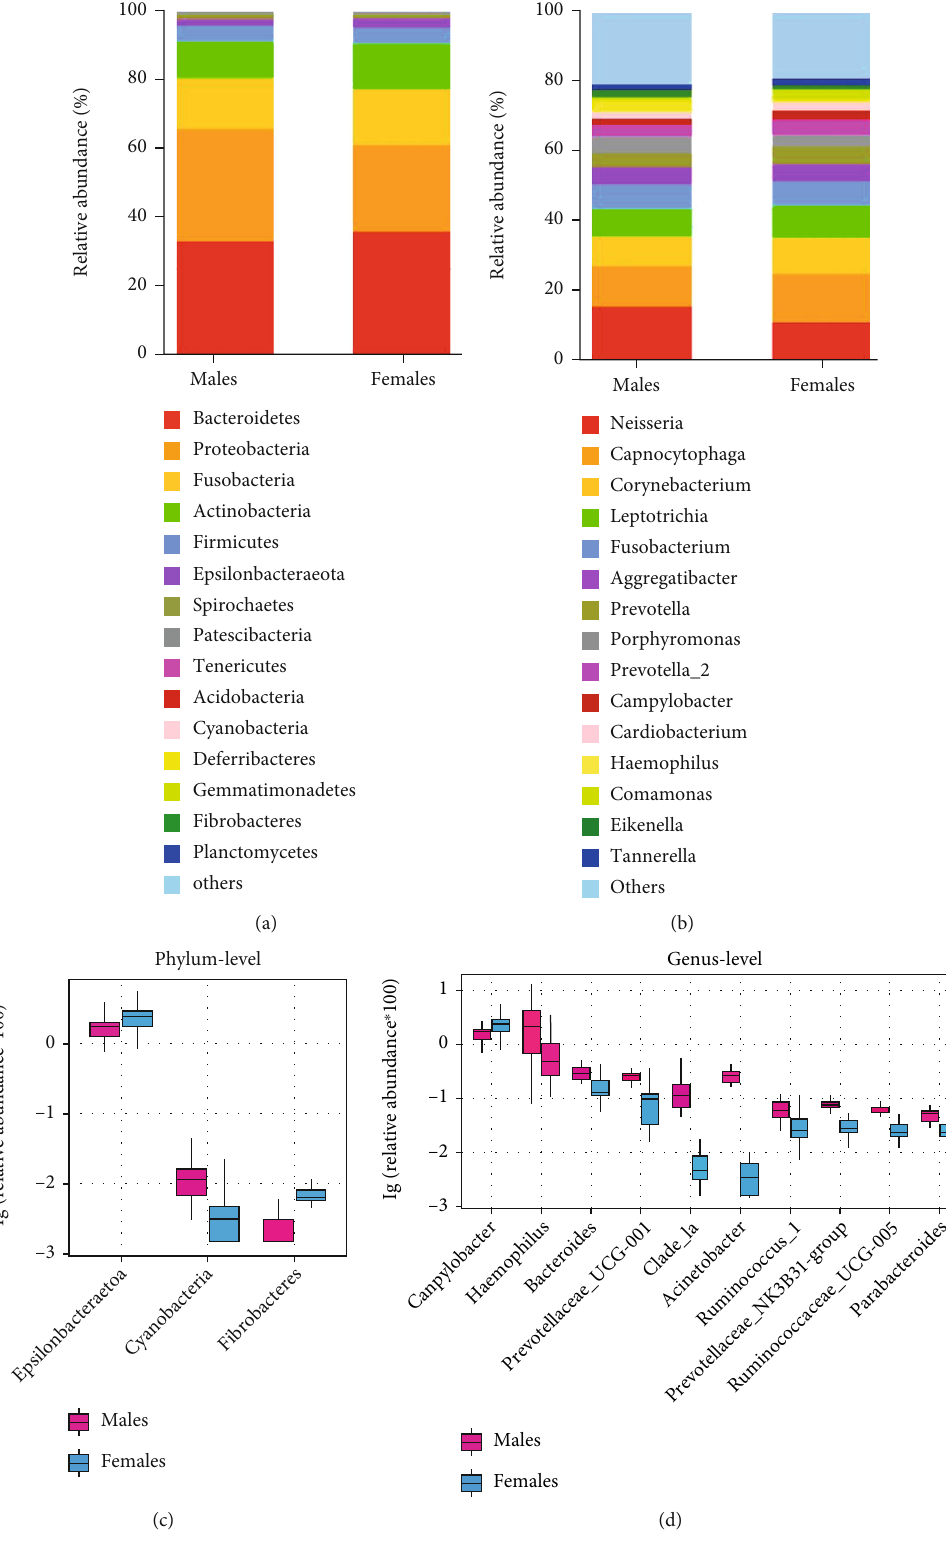
Figure 3: The oral microbiome composition of elderly males and females with stage 1 periodontitis. (a) Phylum level and (b) genus level composition. (c) Species di ff erence analysis between males and females (group 2) by the Kruskal-Wallis test at the phylum and (d) genus